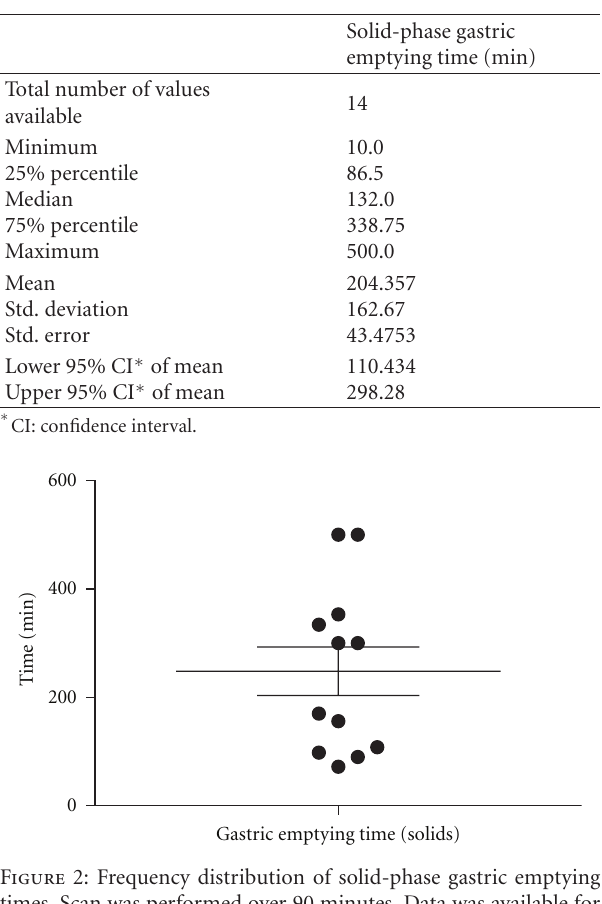
Table 3: Summary of solid-phase gastric emptying time (minutes).